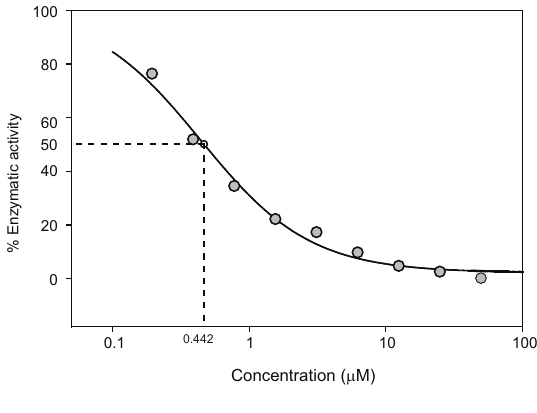
, denoted in the 50 values. 50